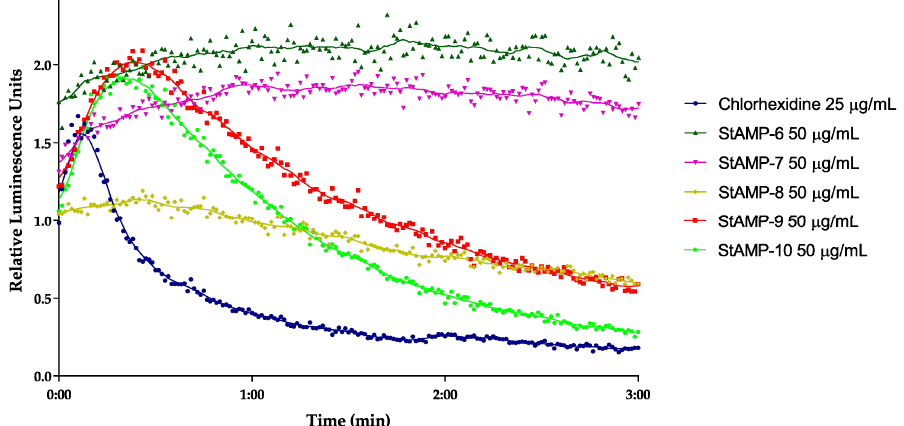
Figure 3. Kinetics of the antimicrobial effect on membrane integrity as measured by relative luminescence emission in B. subtilis 168 (pCSS962) in presence of D-luciferin. StAMP-6-10 and the reference antimicrobial agent chlorhexidine was added to the bacteria. Chlorhexidine served as a positive (membranolytic) control and water as a negative (untreated) control. Each datapoint is the mean of three independent measurements normalized to the negative control.